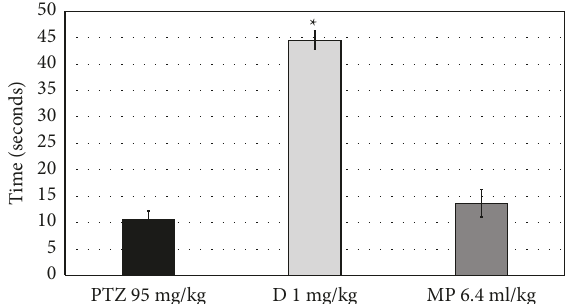
Figure 5: Effects of MPO (6.4ml/kg) on the latency time to the first convulsion in PTZ-induced epilepsy model in mice, ∗ P < 0 . 5 when contrasted to the PTZ group. PTZ: pentylenetetrazol, D: diazepam, MP: Mentha piperita L . oil.